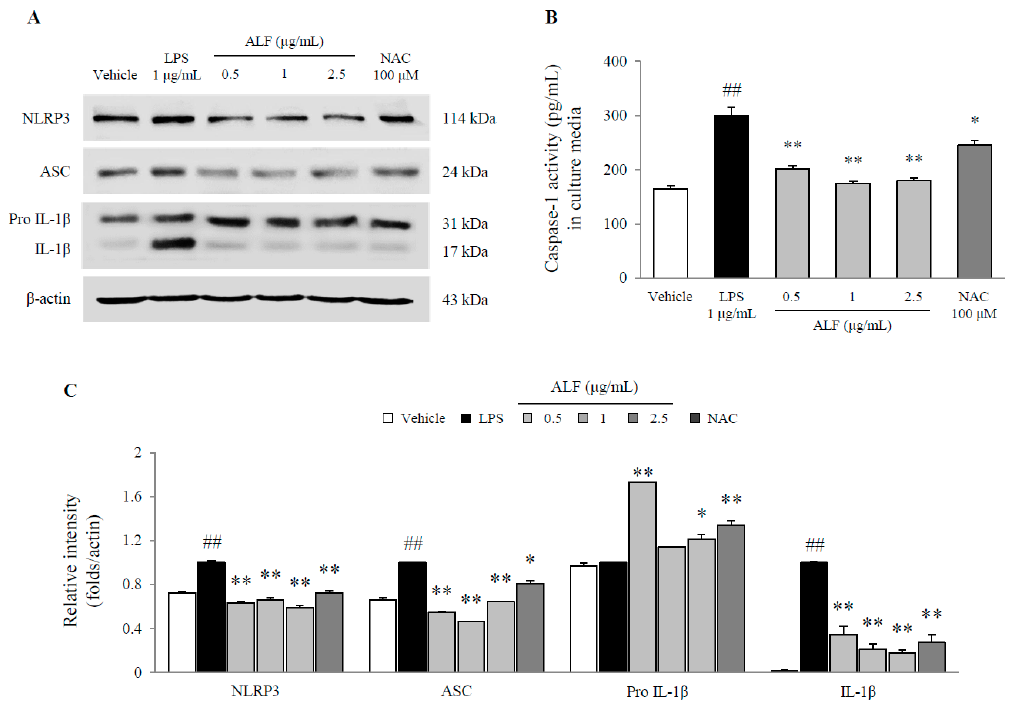
Figure 6. NACHT, LRR, and PYD domain-containing protein 3 (NLRP3) inflammasome pathway in BV2 cells. Protein expression of NLRP3, ASC, and pro and mature-IL-1 β was determined using Western blot ( A ). Caspase-1 activity in cell lysates was determined using ELISA ( B ). Semiquantification of the protein expression was performed with normalization to β -actin ( C ). The data are expressed as the mean ± SD ( n = 3). ## p < 0.01 compared with the vehicle-treated cells; * p < 0.05 and ** p < 0.01 compared with the LPS-treated BV2 cells.